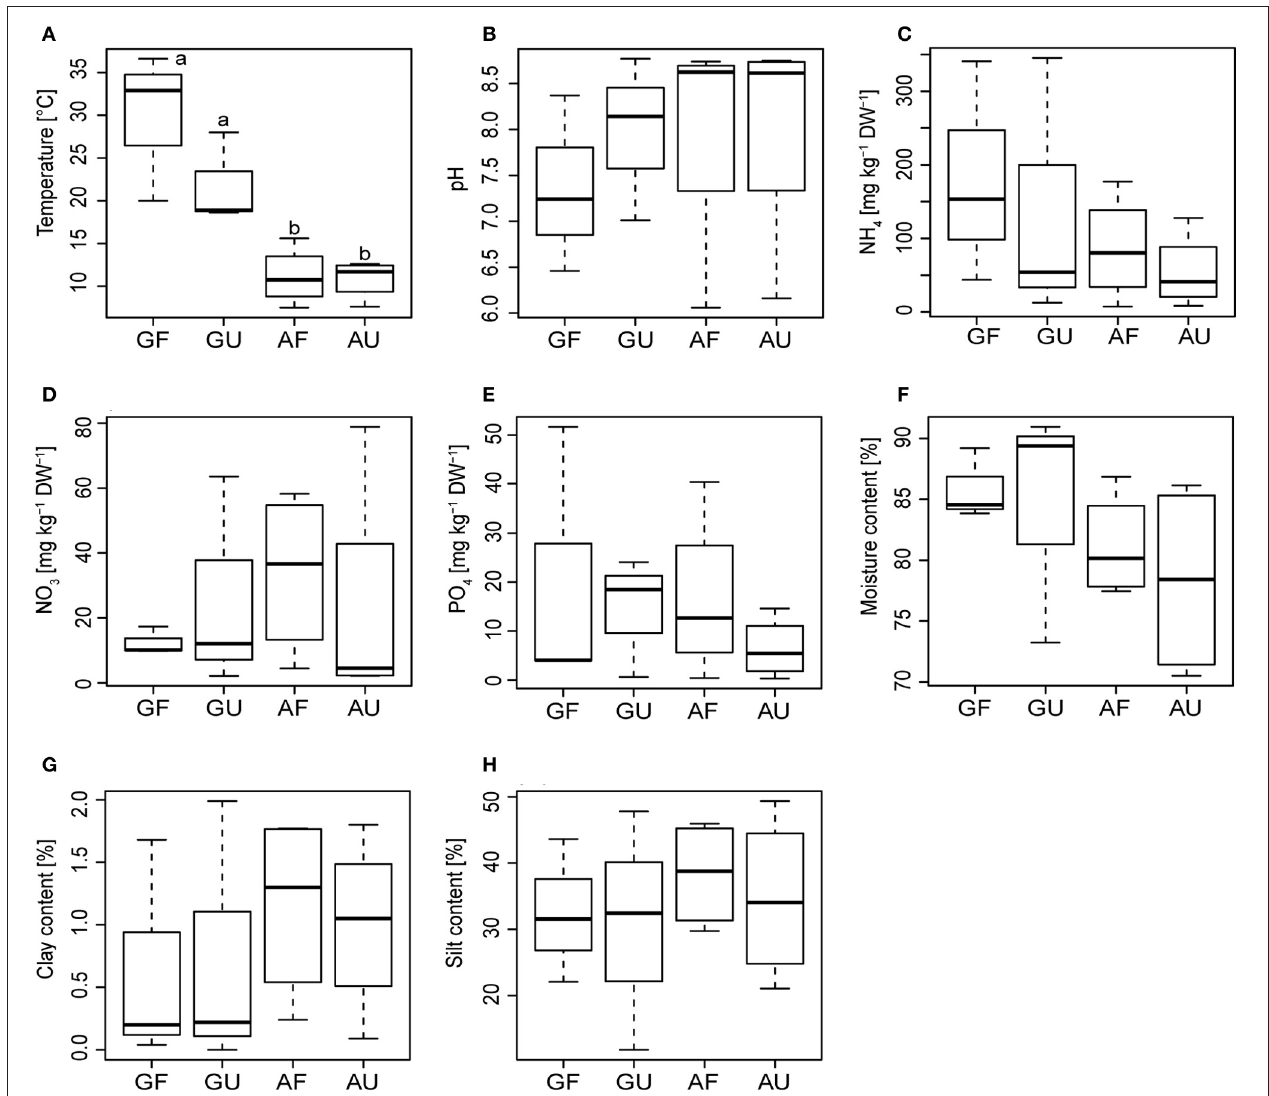
FIGURE 1 | Boxplots ( n = 3–4 samples) depicting the soil physico-chemical properties of the four soil groups. The median is indicated at the midpoint, the hinges indicate the upper and lower quantiles, and the lines represent the spread. Small cap letters in (A) indicate significant